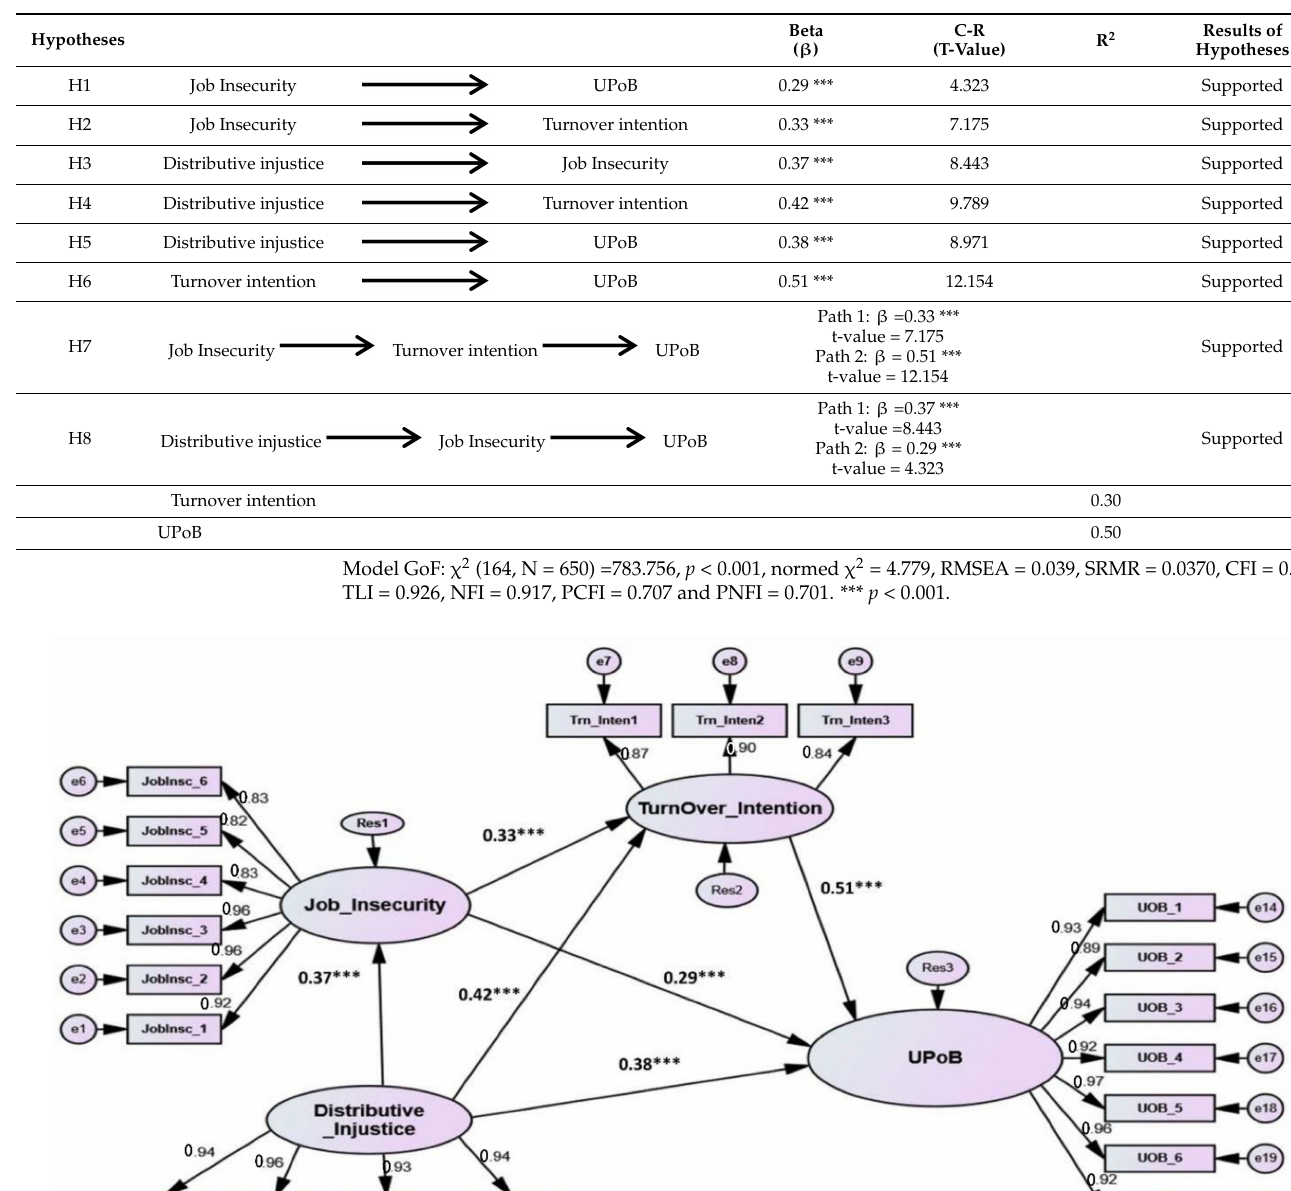
Table 4. The structural model’s results.